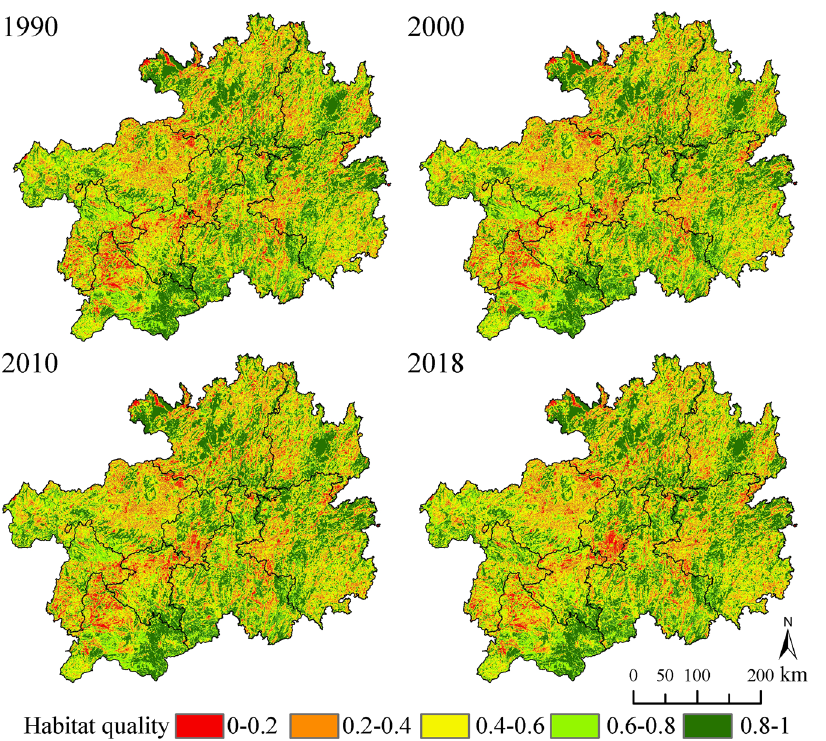
Figure 3. Spatio-temporal patterns of HQ over the 1990–2018